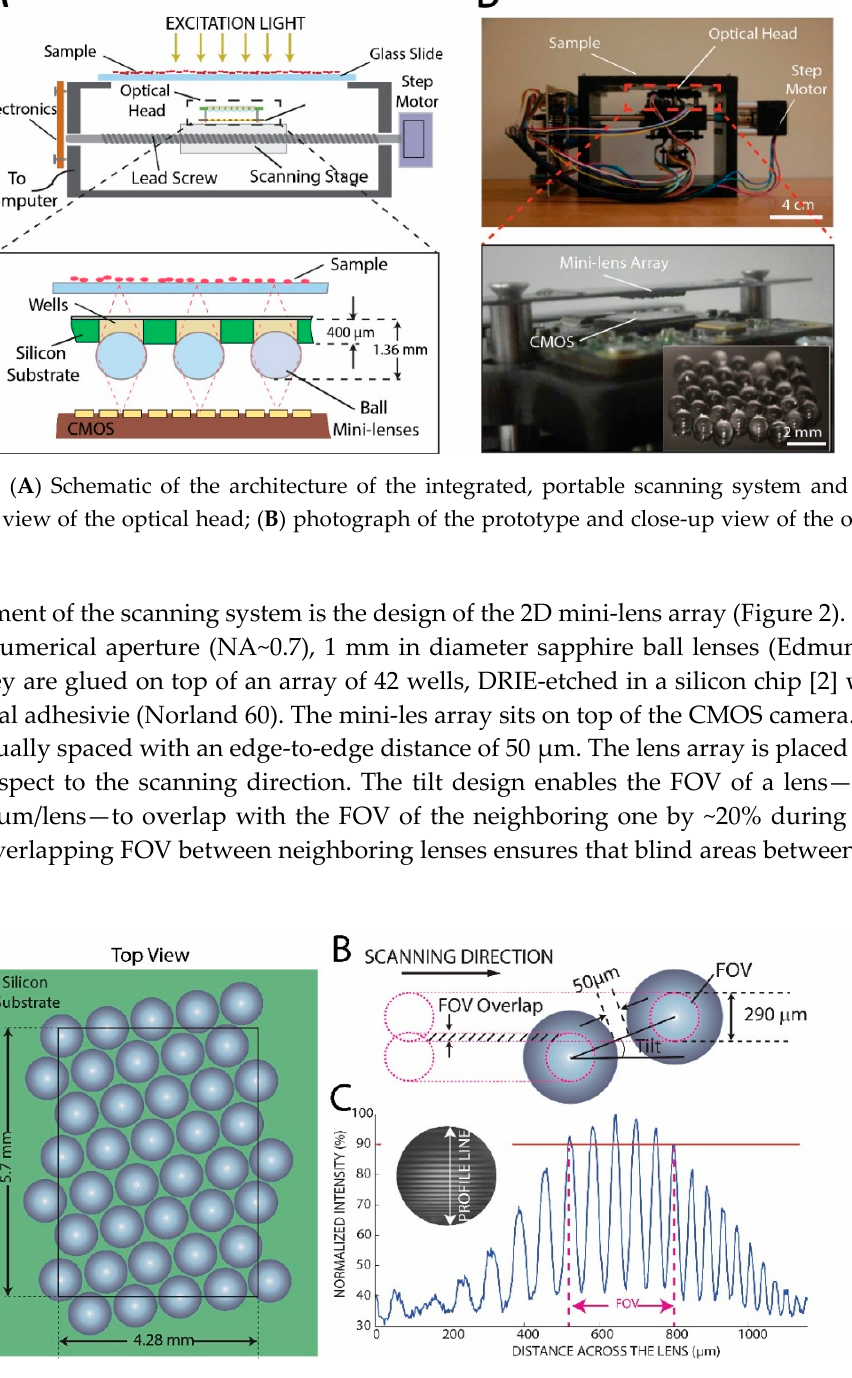
Figure 2. ( A ) Top view schematic of the mini-lens array. The black, dotted outline indicates the effecting imaging area of the CMOS sensor, the green rectangular represents the silicon chip; ( B ) The tilt (17°) of the mini-lens array and the overlap between the FOV of neighboring lenses are crucial for covering the blind areas between the lenses; ( C ) Estimation of the FOV of a lens (~290 μ m) based on a grid of lines imaged with the CMOS sensor in 1× magnification. The FOV is the diameter where the light intensity is 90% of its maximum